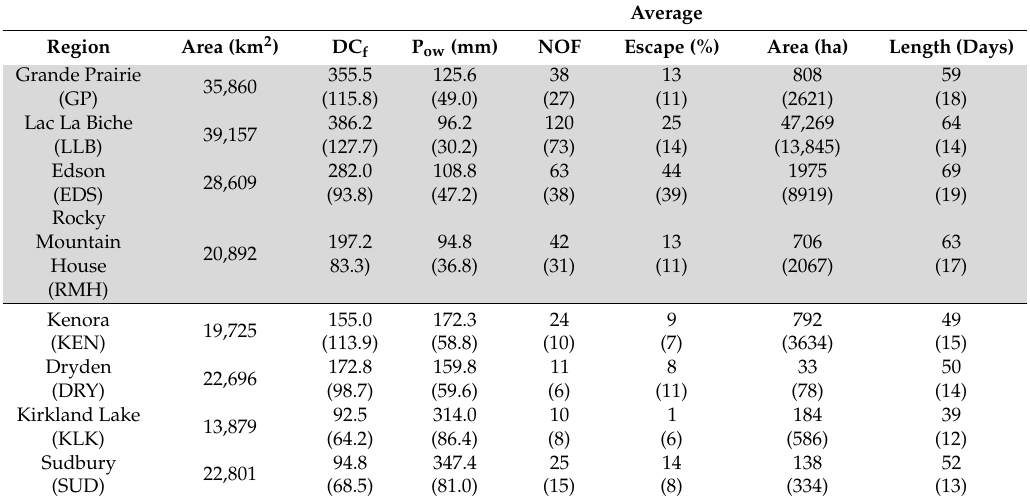
Table 1. Comparison of the fire management regions used in the analysis, including area of each region, average annual previous fall DC (DC f ), overwinter precipitation (P ow ), number of spring human-caused fires (NOF), annual proportion of spring fires escaping initial attack (Escape), annual spring area burned (SAB), and spring fire season length (Length). Standard deviations are indicated in brackets. Regions shaded in grey are within the province of Alberta; the remainder are in Ontario.